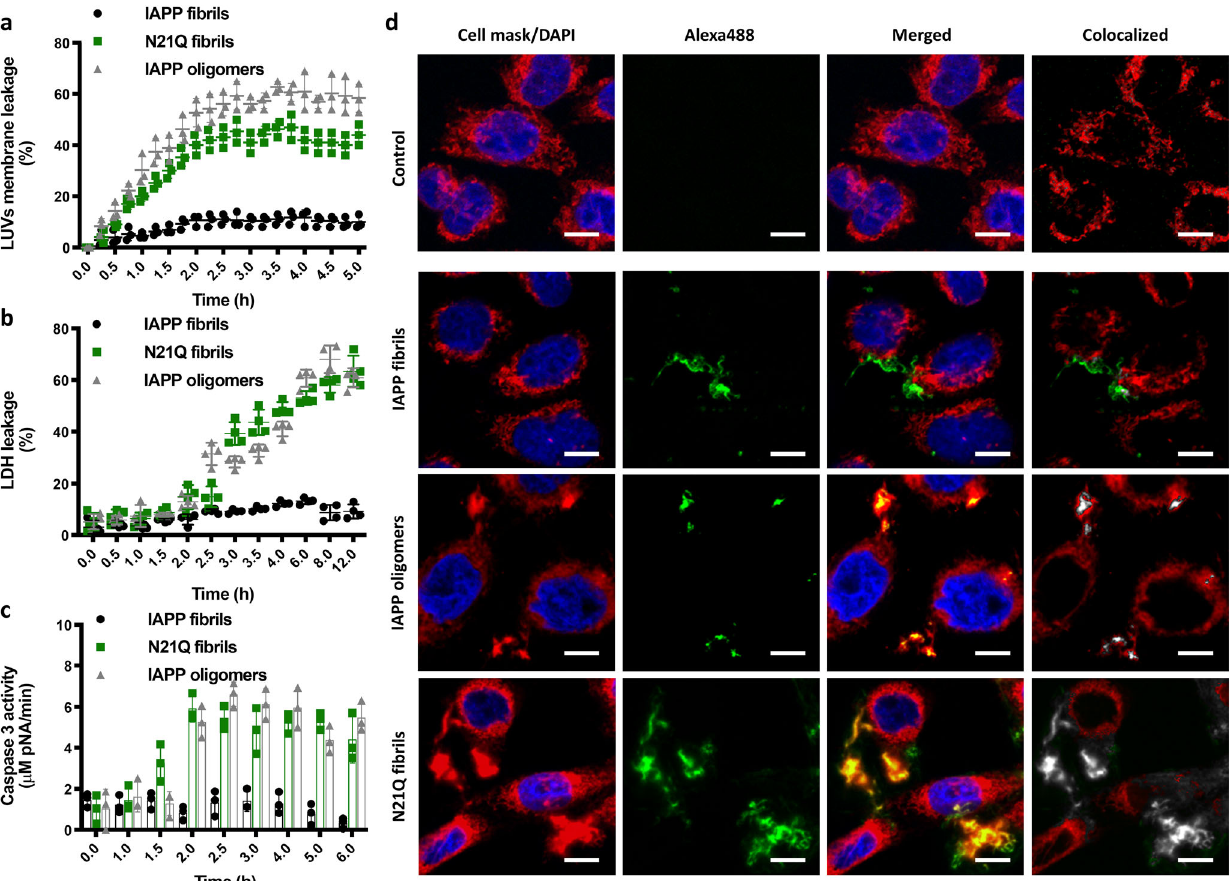
Fig. 6 N21Q fi brils disrupt lipid vesicles and plasma membrane. a Membrane leakage of 500 µ M DOPC:DOPG LUVs (7:3) by 50 μ M oligomers and fi brils. b LDH release from INS-1E cells incubated with 50 μ M fi brils and oligomers for different times. c Caspase-3 activation upon incubation of INS-1E cells with 50 μ M fi brils and oligomers for different treatment times. d Representative fl uorescent confocal images of CHO-K1 cells treated with Alexa Fluor-488 labelled (green) fi brils and oligomers. Cell nuclei and plasma membrane were stained in blue and red, respectively. Scale bar: 10 μ m. a , b Oligomers and fi brils were assembled from monomerized peptides incubated under quiescent conditions for 15 min (oligomers) and 48 h ( fi brils) at 150 µ M in 20 mM Tris-HCl buffer, pH